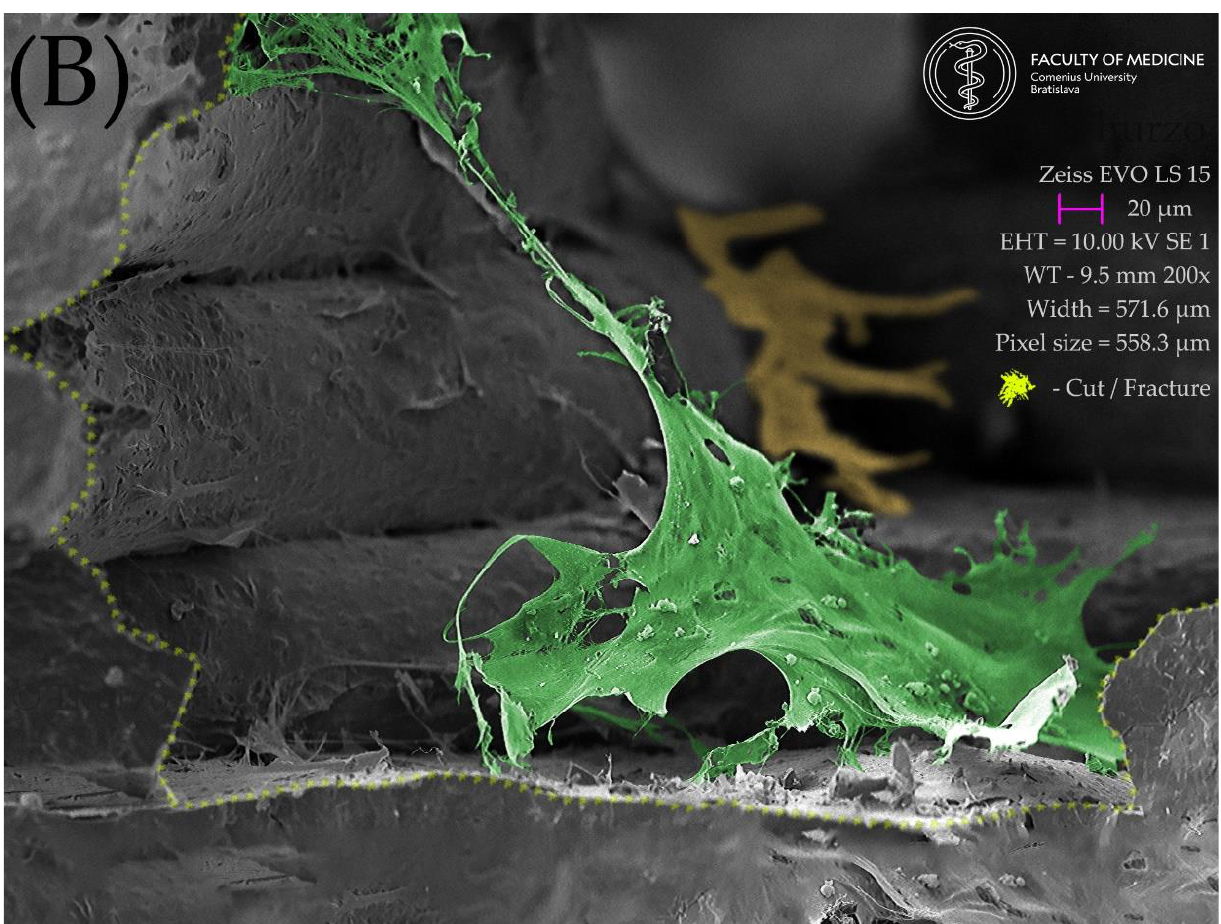
Figure 9. Lateral view of the interior of the scaffold floor, created with an ultra-sharp razor blade. A large flat cell in the foreground shows exceptionally long cell projections firmly attached to the lateral surfaces of the scaffold. The openings between the scaffold lines appear to be a friendly environment for cell growth: ( A ) original SEM image; ( B ) enhanced image showing the scaffold section and the green-colored cell attached to the scaffold from bottom to the top, with a yellow-colored cell in the background climbing up in the posterior corner of the scaffold.